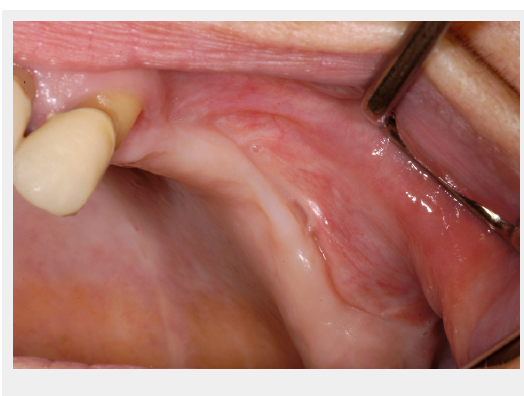
Same patient as figure 2 shows the situation after surgical treatment of BRONJ with complete remission without any remaining dehiscence of the soft